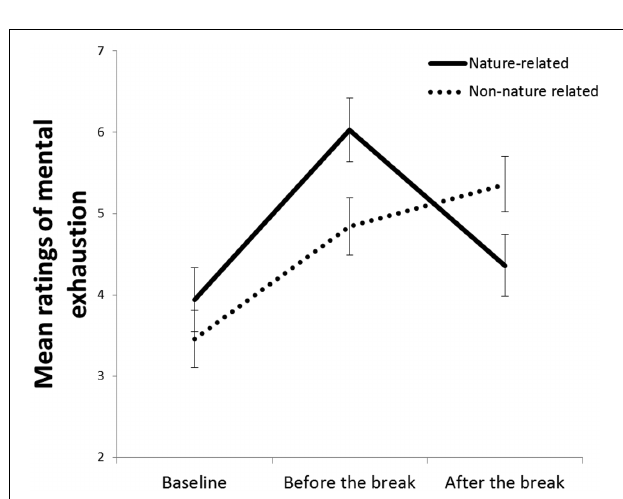
FIGURE 3 | Mean ratings of the mental exhaustion index across the three times of data collection for participants in the control condition who spontaneously attributed the sound to a nature-related source and those in the same condition who attributed the sound to a non-nature related source. Error bars represent standard error of